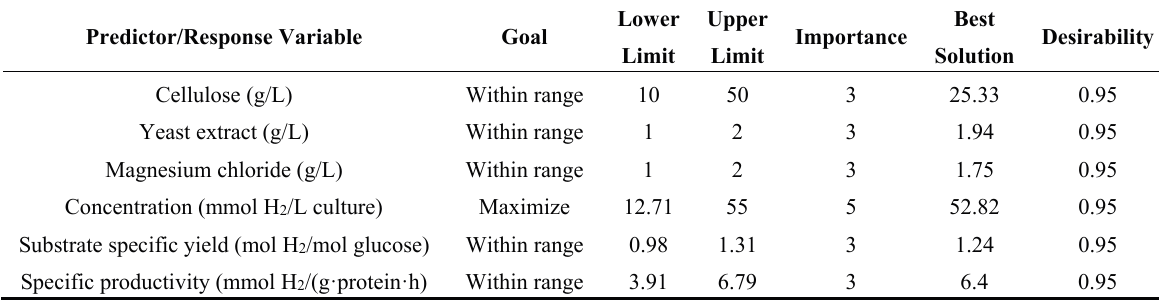
Table 6. Components of the desirability function applied to obtain a balanced optimum for H 2